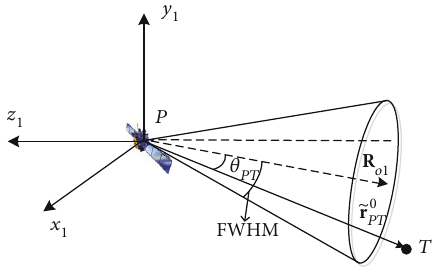
Figure 3: The constraint of fi eld of